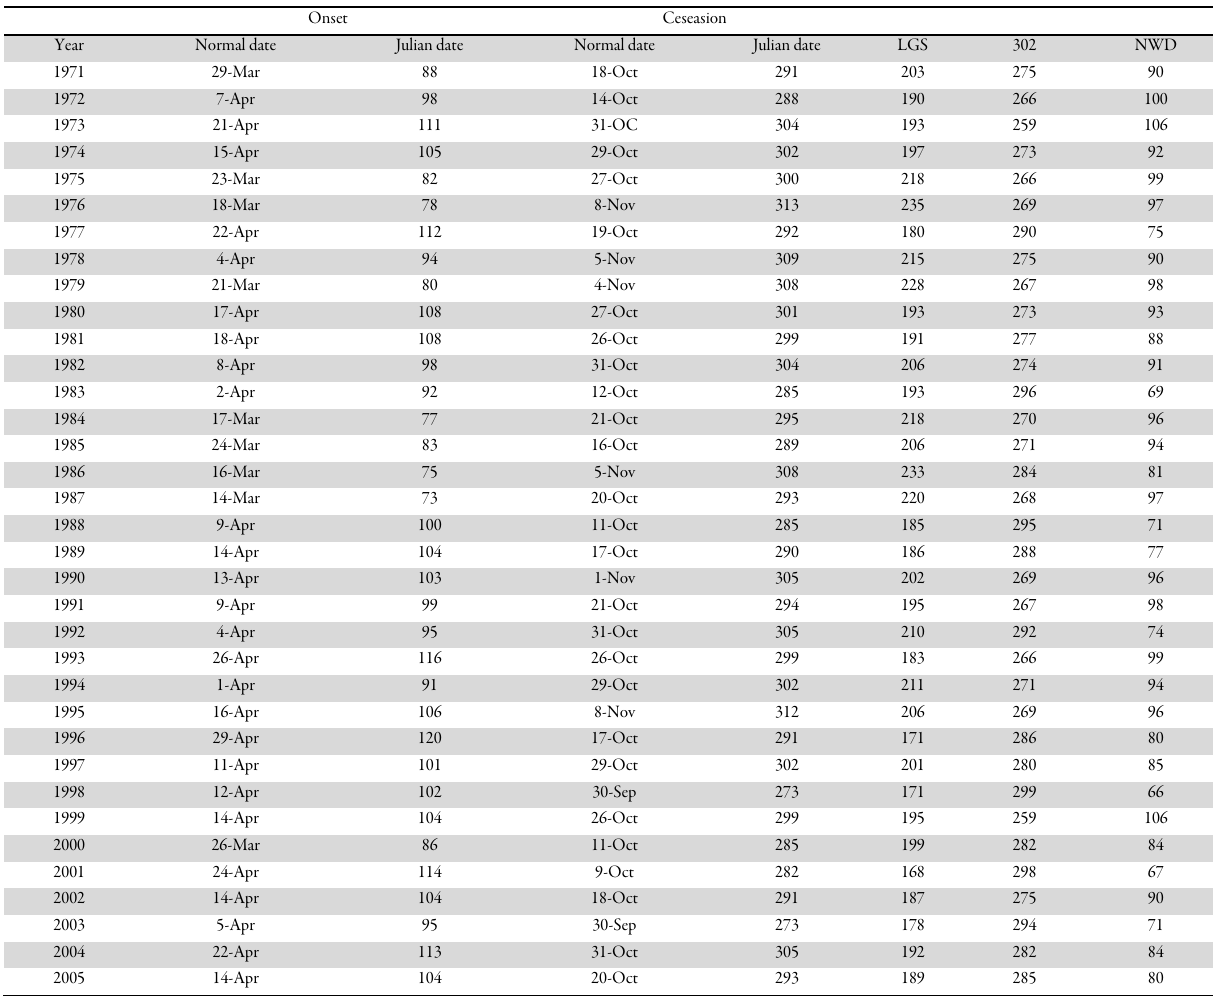
Table 3. Onset, cessation, length of growing season (LGS), number of dry days (NDD) and number of wet days (NWD) in Ilorin